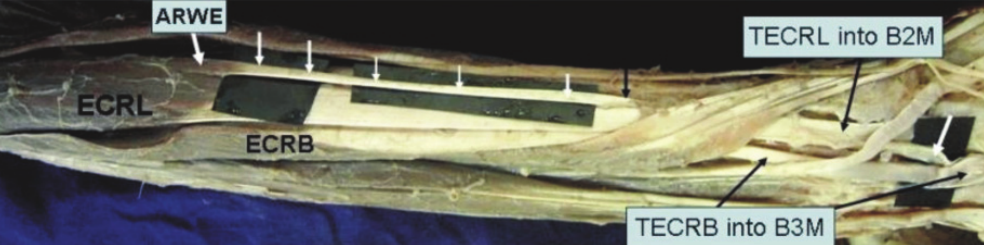
Figure 5 - Extensor compartment of the right forearm and hand region. TECRB into B3M, tendon of extensor carpi radialis brevis inserted into the base of the third metacarpal bone; TECRL into B2M, tendon of extensor carpi radialis longus inserted into the base of the second metacarpal bone. Note the downward arrows, which indicate the course of the additional